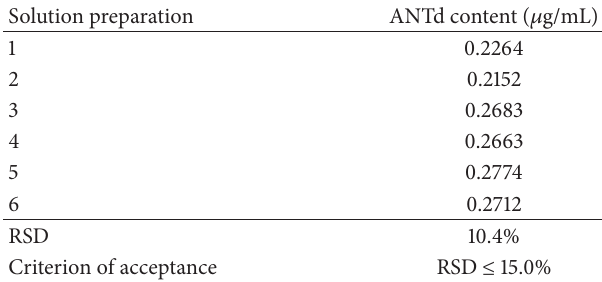
Figure 8 is the chromatogram of LOQ solution (0.1554 𝜇 g/mL).